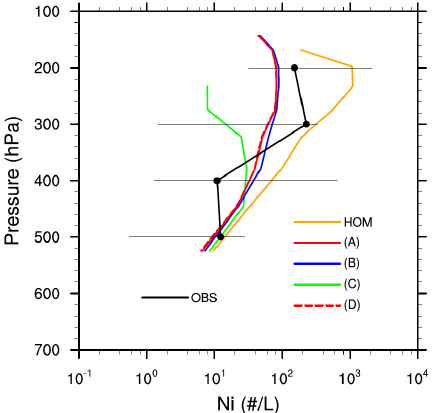
Figure 5. Monthly mean profiles of the simulated in-cloud ice crystal number concentrations ( Ni ∼ N ice ) over the ARM SGP site. The four cases shown in the figure include the pure homogeneous ice nucleation case (HOM) and four combined (heterogeneous + homogeneous) ice nucleation cases: (a) AIDA interpolated + homogeneous; (b) AIDA fit + homogeneous; (c) P13 + homogeneous; and (d) AIDA = 105%) + homogeneous. Black dots show the interpolated (RH ∗ i observed mean profile of Ni . Left and right ends of the horizontal bars indicate the 10th and 90th percentiles of the observed Ni values at each pressure level.